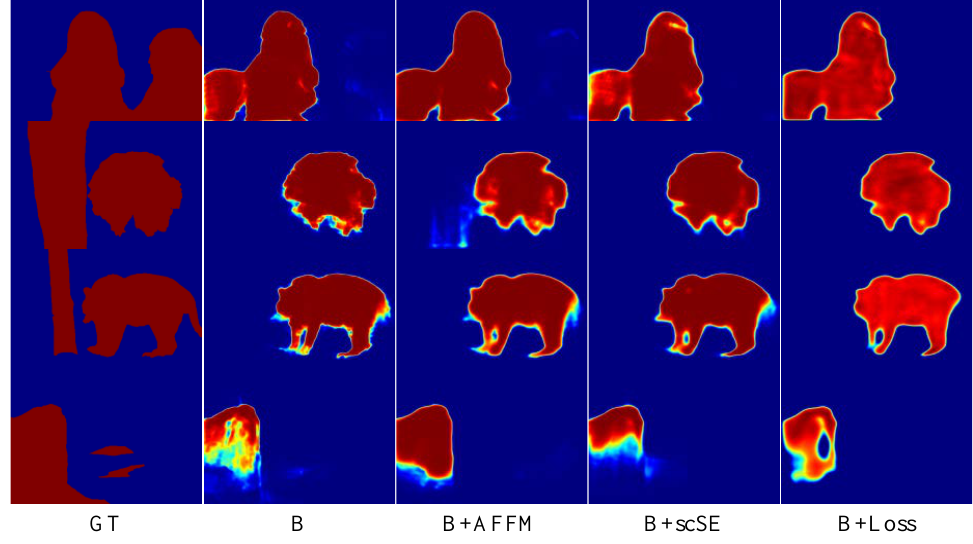
Figure 7. The comparison of different combinations with the backbone.